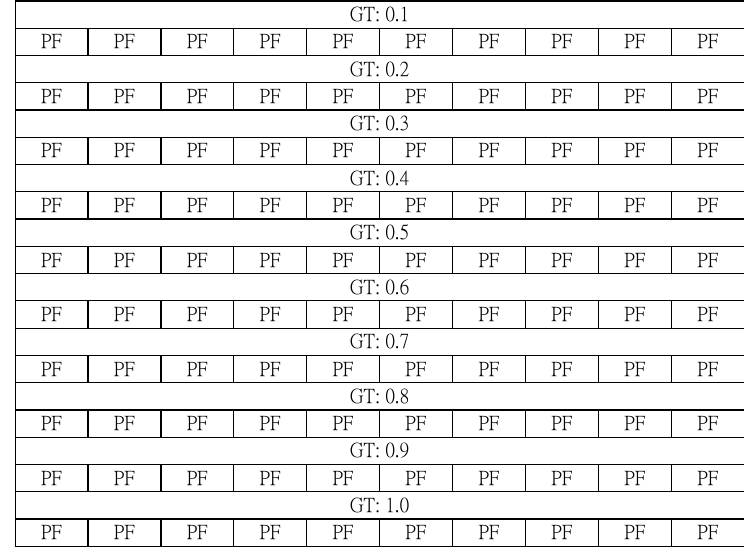
Figure 7. The XPF in the empty state ( 𝐏𝐚𝐜𝐤𝐞𝐭𝐒𝐢𝐳𝐞 × 𝐍 × 𝐍 × 𝐍 ).